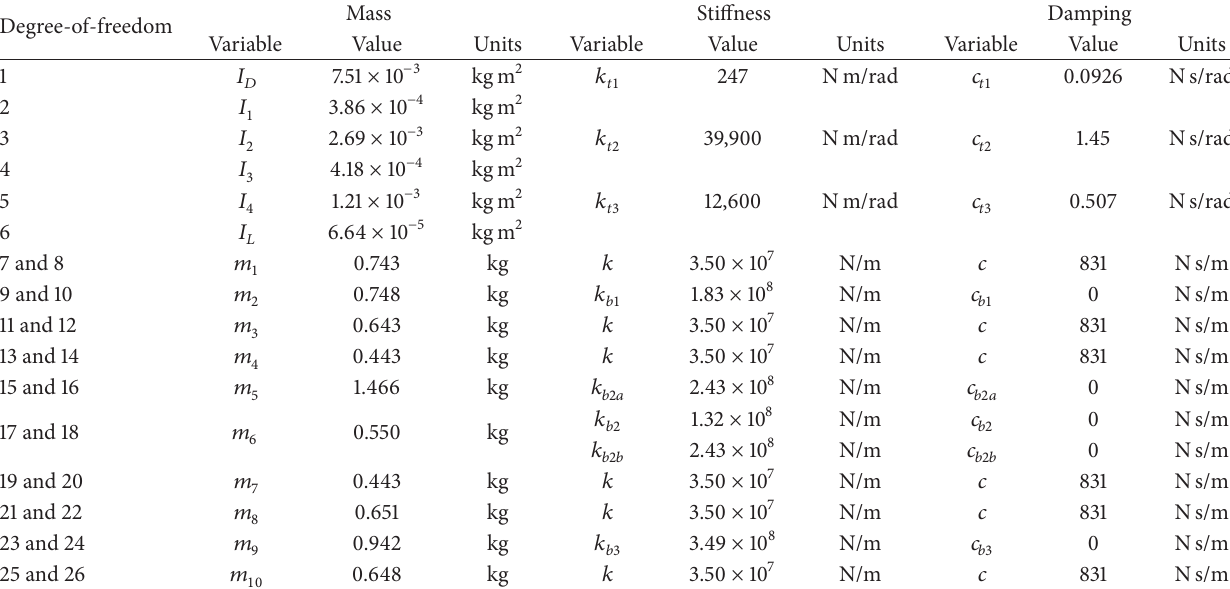
Table 1: Parameters used in dynamic gear model.